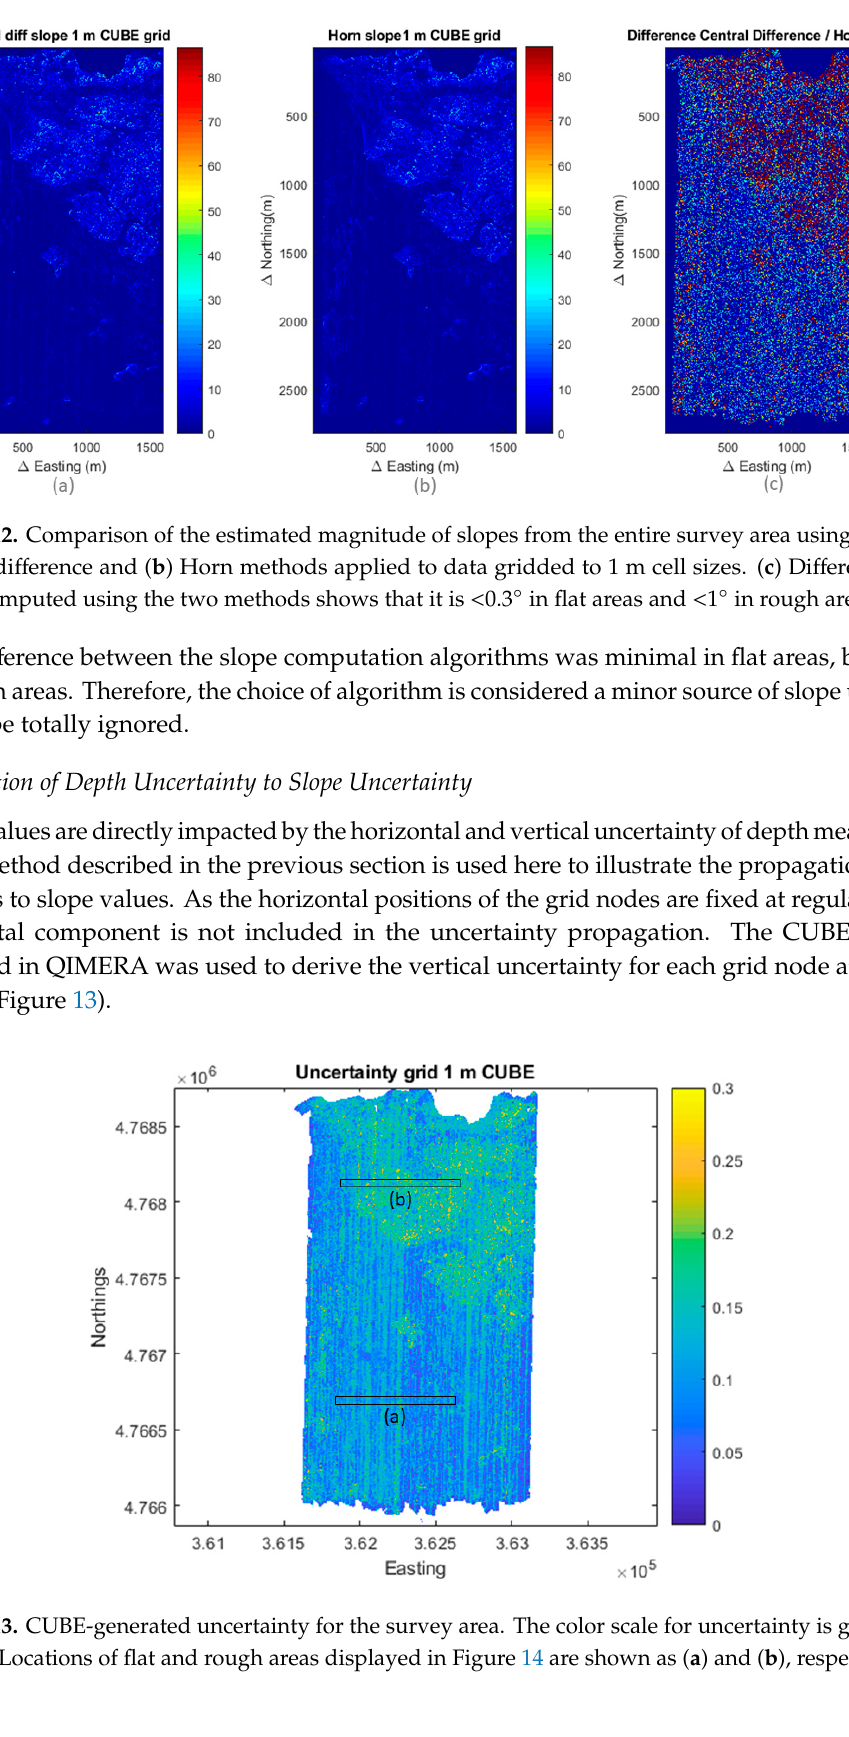
Figure 11. Comparison of slopes from three different estimation methods: “Ping” method (black dots), where all the soundings from a ping are used to compute across-track slope show large differences, from “Horn” (red circles) and “central difference” (black diamonds) methods, where 1 m grid cell size bathymetry is used to compute across-track slopes.